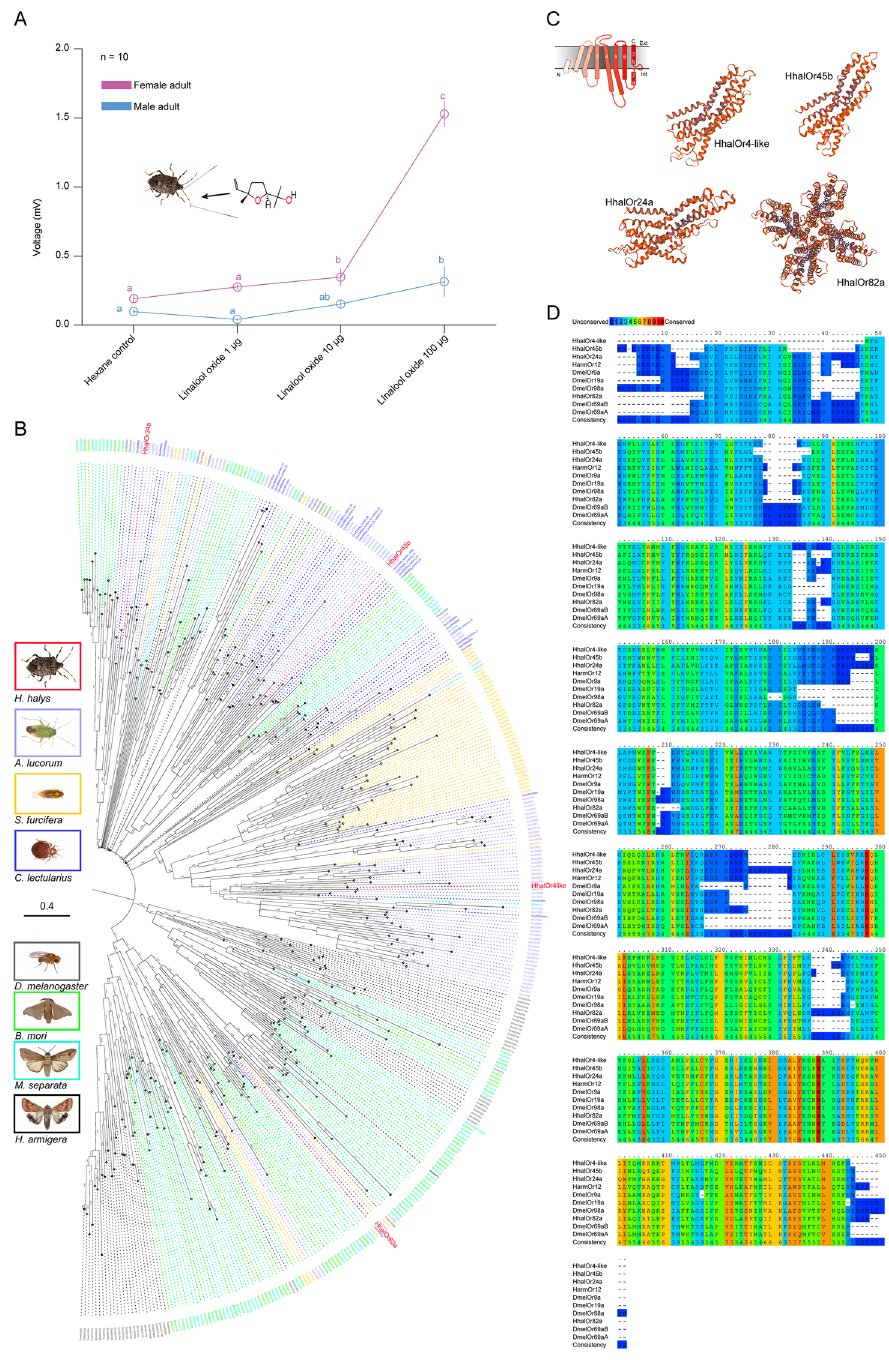
Figure 2. Olfactory evidences of H. halys in sensing linalool oxide. ( A ) Results of electroantennogram tests with linalool oxide. Lower-case letters indicate significant differences among tested dosages in either male or female adults. (GLM and Tukey HSD multiple comparison. P < 0.05. Error bars indicate ± s.e.m.) ( B ) Phylogenetic analysis of putative linalool sensing odorant receptors of H. halys by referring to ORs from A. lucorum , S. furcifera , C. lectularius , D. melanogaster , B. mori , M. separata , and H. armigera . The evolutionary history was inferred by using the Maximum Likelihood method and the JTT matrix-based model. The tree with the highest log likelihood (− 2,980,075.06) is shown. Initial tree(s) for the heuristic search were obtained automatically by applying Neighbor-Join and BioNJ algorithms to a matrix of pairwise distances estimated using the JTT model, and then selecting the topology with superior log likelihood value. This analysis involved 374 amino acid sequences. There were a total of 1344 positions in the final dataset. Evolutionary analyses were conducted in MEGA X. ( C ) Structural predictions of four putative linalool sensing ORs in H. halys , with modeling re-constructed referring to known Cryo-EM structures of insect ORco ( Apocrypta bakeri ORco: 6c70.1.A) Schematic shows representative 7-TMD structure of insect OR. All four ORs showed 7-TMD structures and potentially tetramer binding activities. Predictions were done with SWISS-MODEL. ( D ) Alignment of the four H. halys ORs with referring to most related linalool sensing ORs in Drosophila and cotton bollworm. Conservations of amino acid residues were indicated with